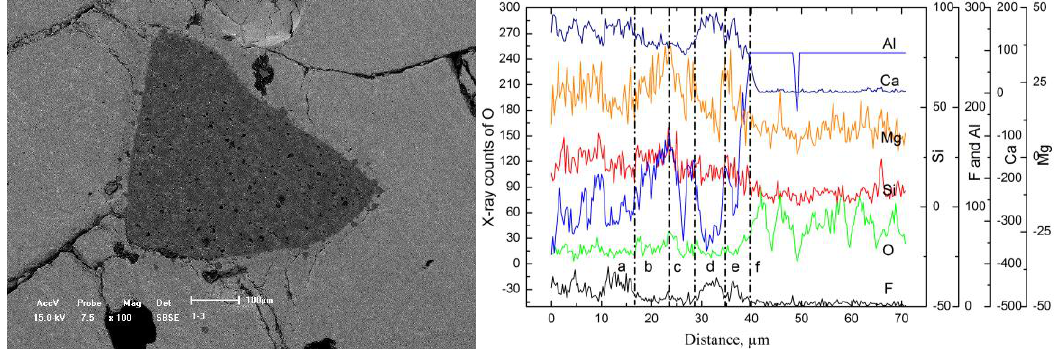
Figure 5. Morphology of alumina particle at another time in slag S1 by SEM-SBSE and line-scanning image of boundary layer.